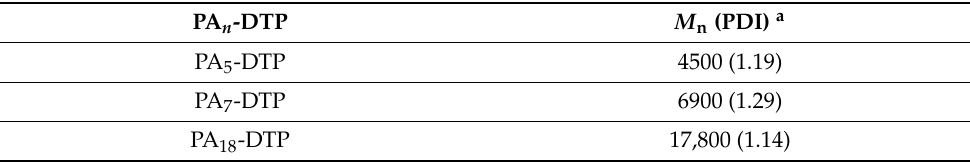
Scheme 1. Synthesis of polyacrylamide (PA) with dithiopyridyl unit (PA n ‐ DTP, n = 5, 7, 18) via RAFT